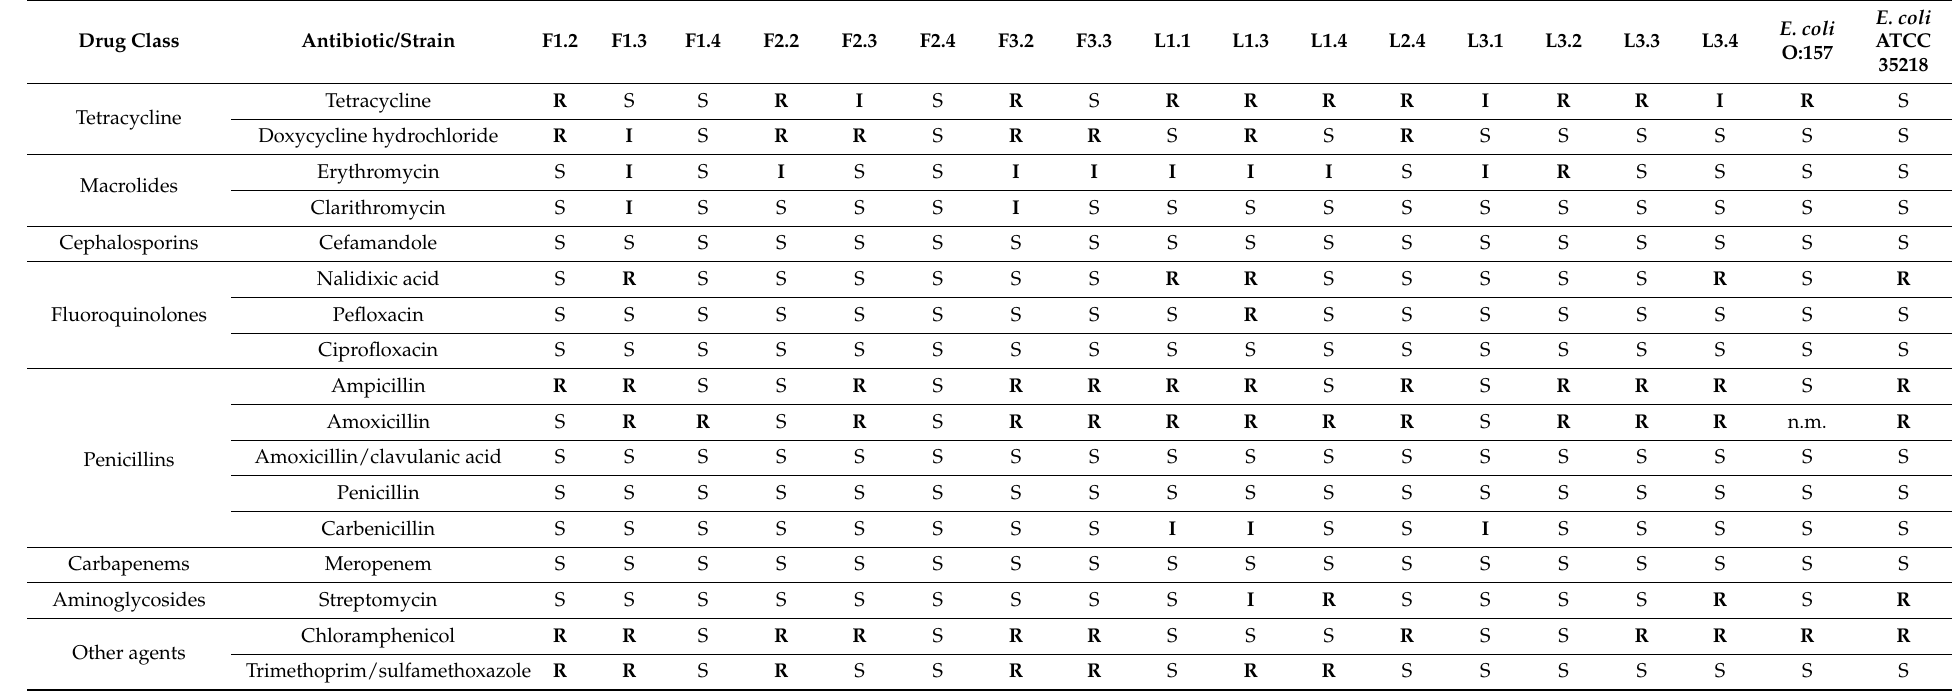
Table 3. Antibiotic resistances by the disc diffusion method of the isolated E. coli